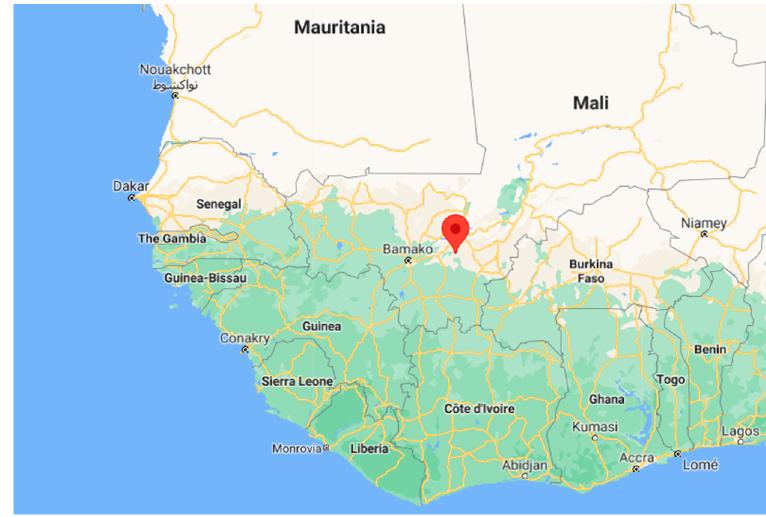
Figure 5. Localization of the microgrid case study.